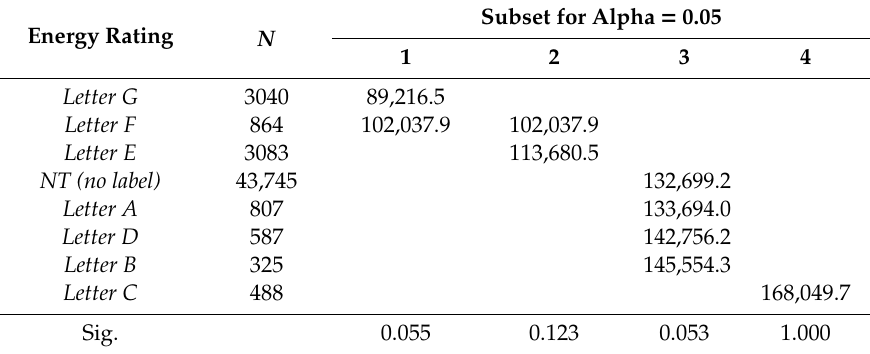
Table 4. Homogenous subsets of the mean asking prices by qualification